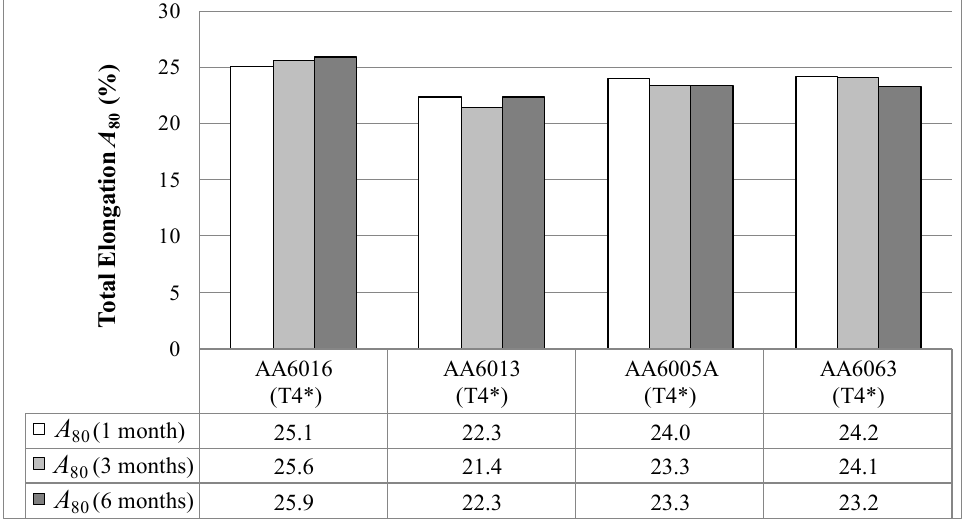
in tempers T4, T4*, m